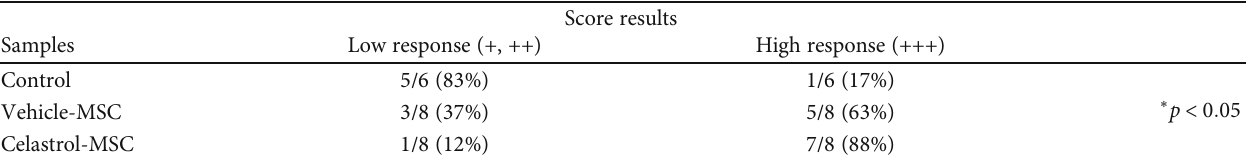
Figure 7: (a) Thickness of the macrophage-rich region around the implant on day 7. The control group was the hydrogel without cells. (b) Representative images showing macrophage in fi ltrations in the peri-implant region for each treatment group; arrows ( ↔ ) illustrate the thickness of the macrophage-rich region (brown, CD68 staining, scale bar 500 μ m), and arrows ( ⇔ ) illustrate the total immune cell in fi ltrations in the peri-implant region. Table 1: Score of neovessel density in the peri-implant region after 7